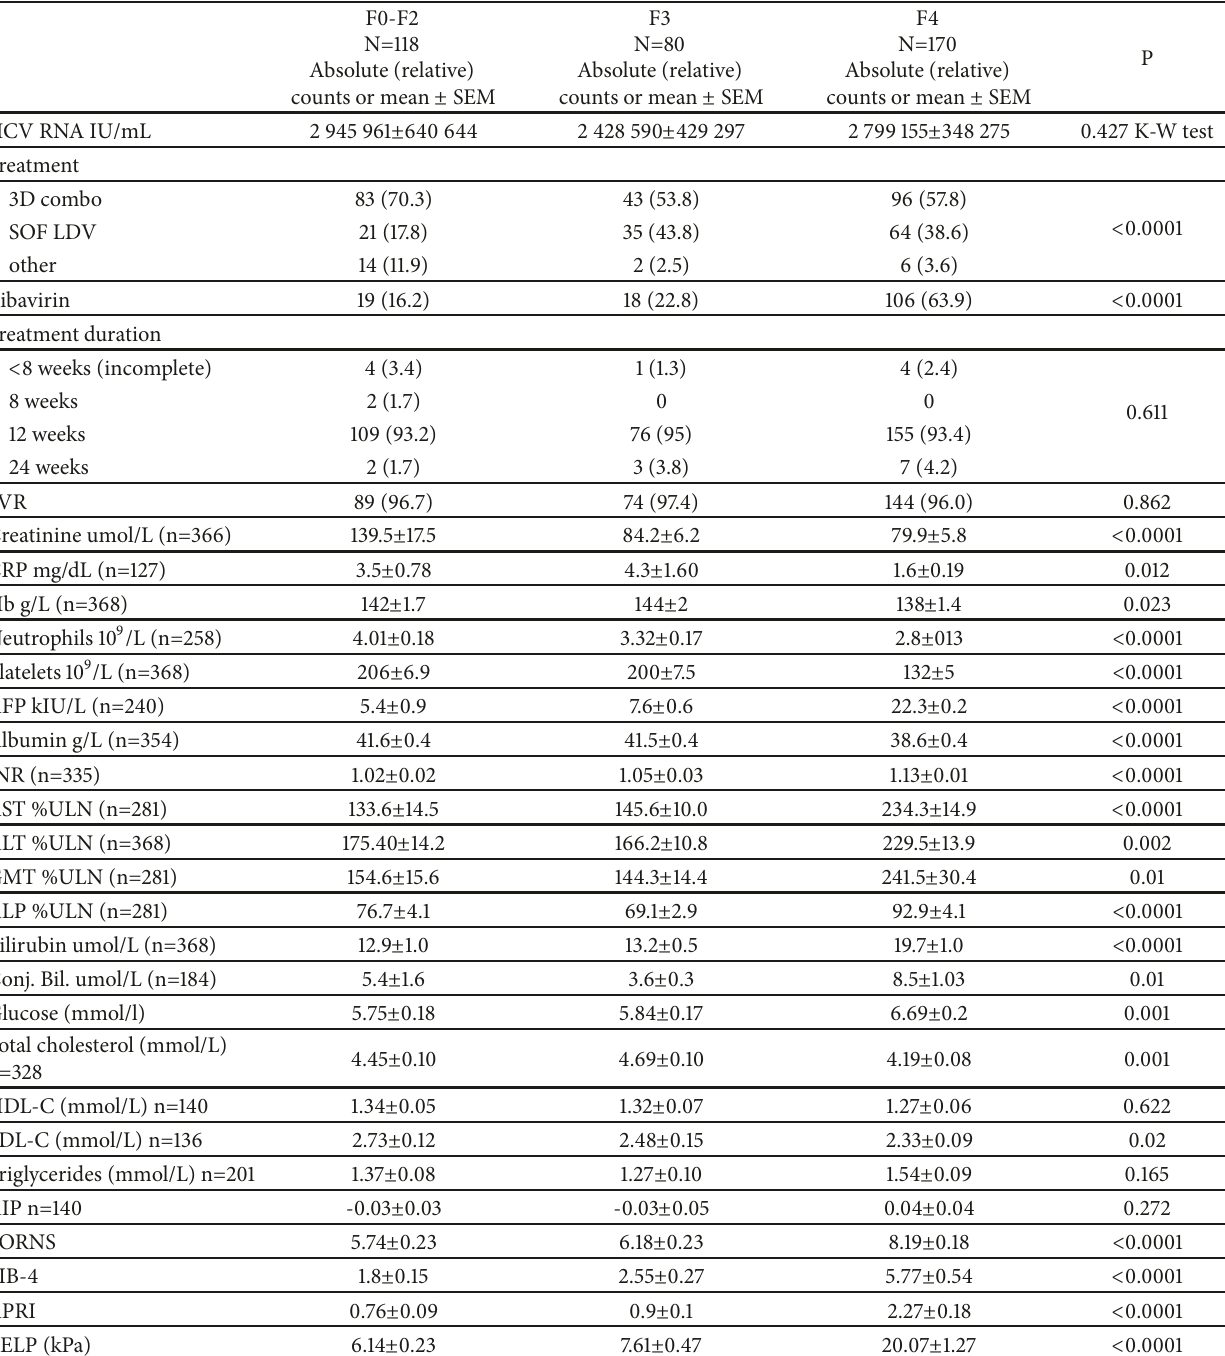
Table 2: Baseline laboratory parameters and DAA treatment parameters by degree of fibrosis.